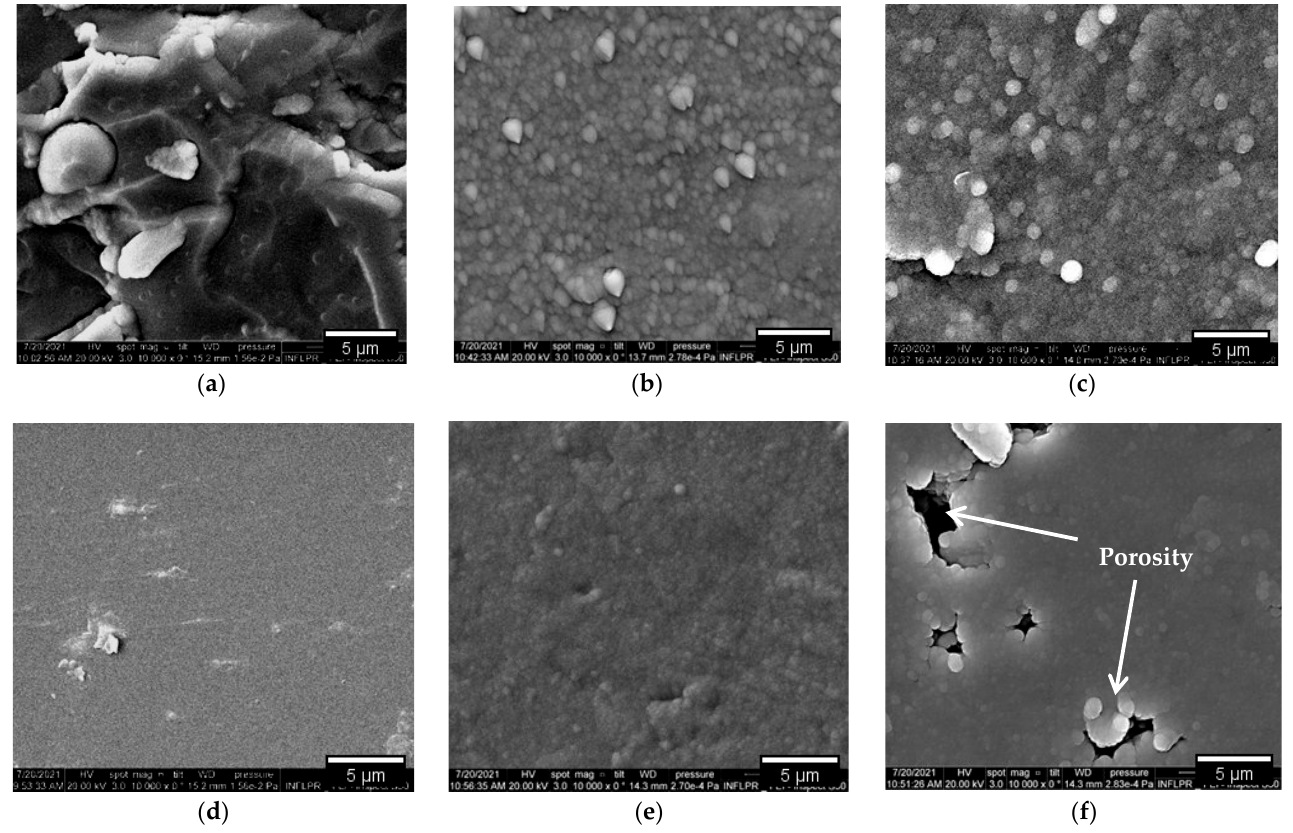
Figure 2. SEM images of oxides and metal-oxides: A1 ( a )—flake-like structures; A2 ( b )—randomized cone shape nucleation, <1.5 µm in diameter; A3 ( c )—sphere/droplet shape nucleation, <2.5 µm in diameter; B1 ( d ) and B2 ( e )—isolated grain formations, <0.5 µm in diameter; B3 ( f )—defects expressed as pores isolated by grains, <2.5 µm in diameter.